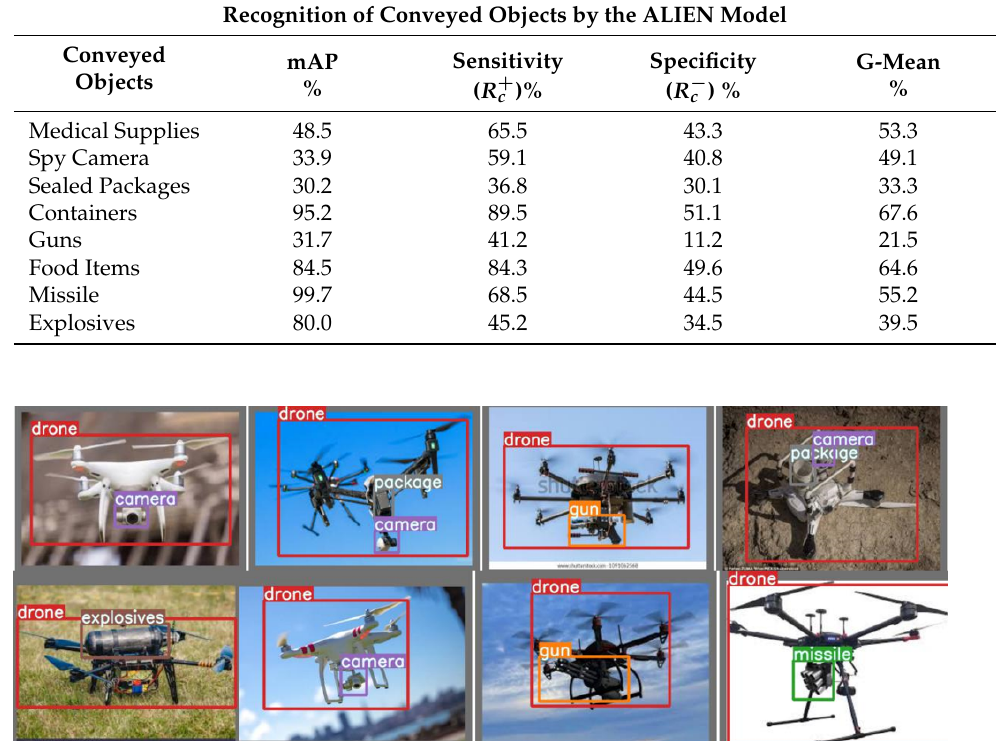
Table 6. Conveyed objects status recognition.